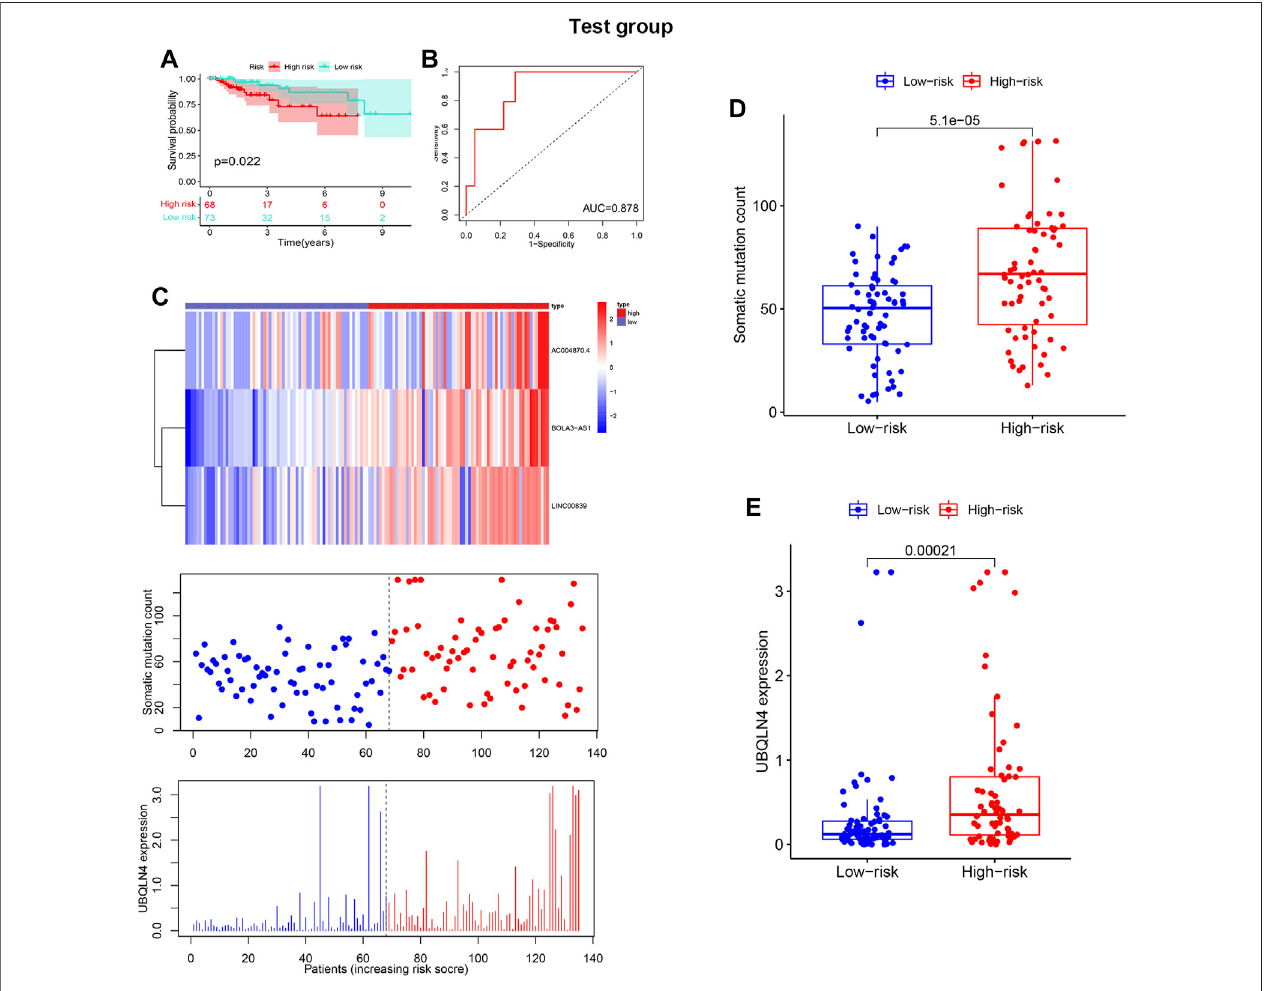
FIGURE5 | Veri fi cation oftheGILncSig inthe test set. (A) . Kaplan – Meier survivalcurvesofGILncSig in the test set. (B) .Receiver operating characteristic curvesof GILncSig in the test set at 3 years. The distribution trend of somatic mutation and UBQLN4 expression increased in correlation with rising GILncSig in the test set (C) . Comparison of overall cell mutation count and UBQLN4 expression level between the risk hi and risk lo groups in the test set (D,E) .